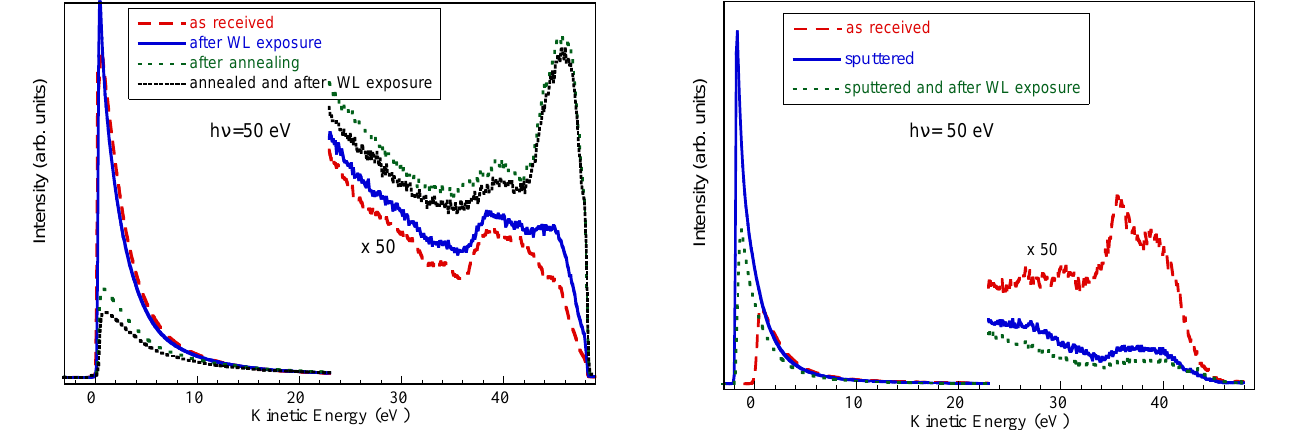
FIG. 11. (Color) The photoemission spectra, taken at 50 eV photon energy, of TiN as received, after Ar 1 sputtering (TiN- sp.), and after WL exposure of the sputtered